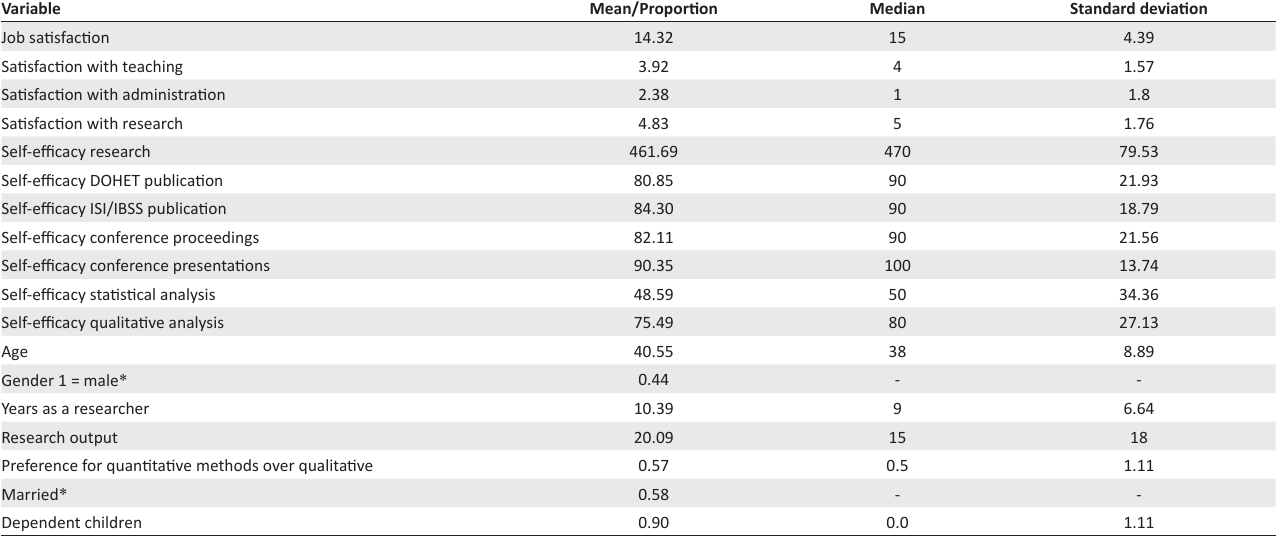
TABLE 2: Descriptive statistics: Doctoral designation.